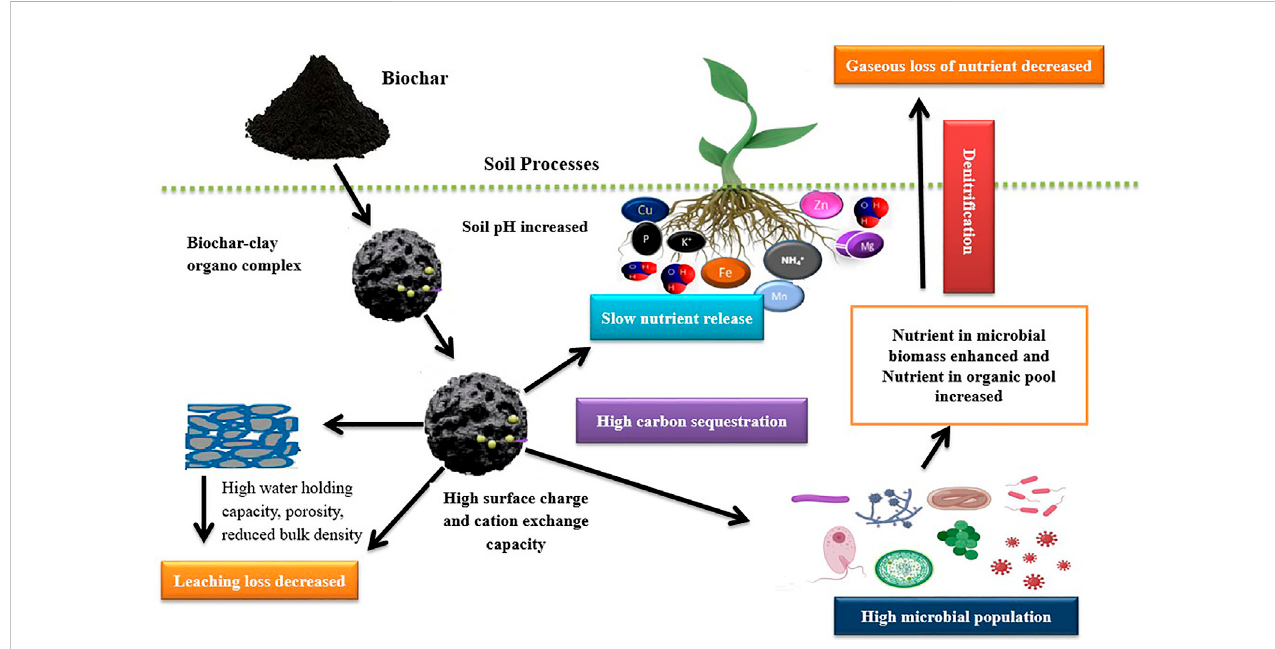
FIGURE 2 Biochar induced modi fi cations in soil properties and its impact on plant growth and development; Copper (Cu), Iron (Fe), Magnesium (Mg), Manganese (Mn), Phosphorus (P), Potassium (K), Ammonium (NH 4 ), Zinc